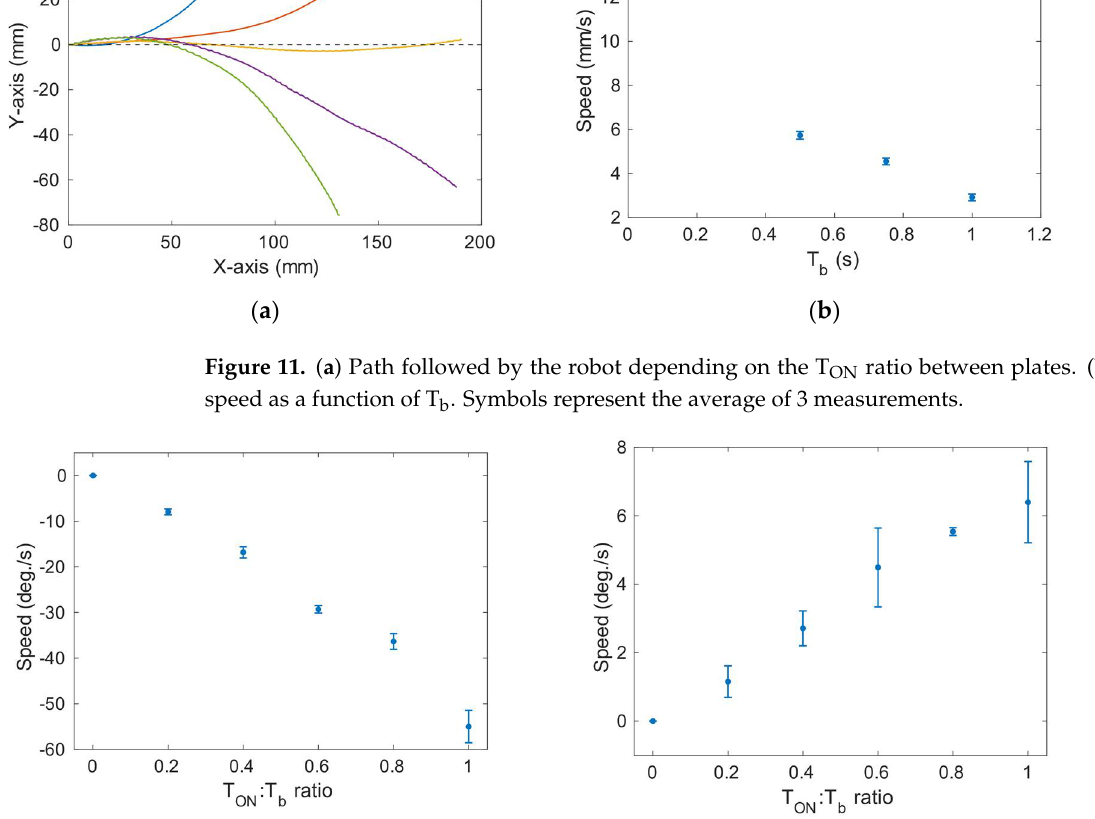
Figure 11. ( a ) Path followed by the robot depending on the T ON ratio between plates. ( b ) Linear speed as a function of T b . Symbols represent the average of 3 measurements.